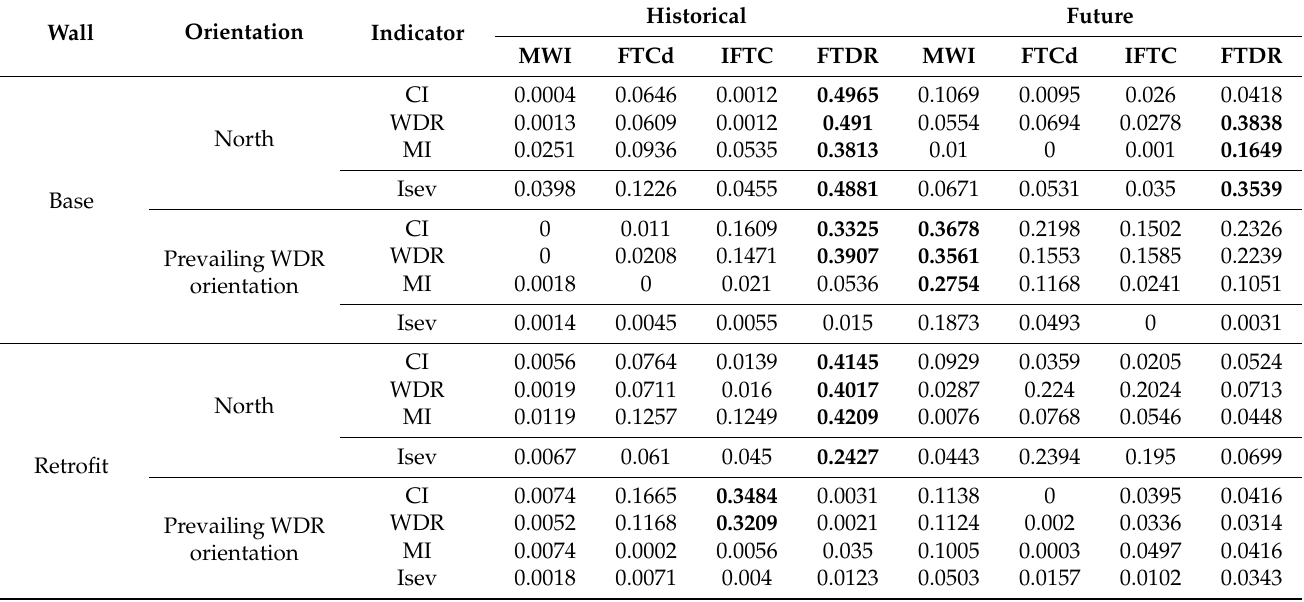
Table 4. The correlation coefficient (R 2 ) between response-based indices values based on their actual ranking, and their corresponding values based on climate-based indices ranking—for a North and WDR oriented reference wall and retrofit wall under historical and future periods in Ottawa. The highest values per index and climate are marked in bold.